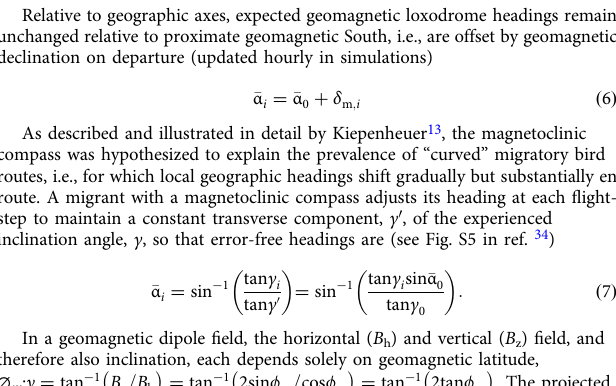
Fig. 8 Relative compass-course performance and cue favourability predicted by distance and spherical-geometry factors. a – i Route-optimized performance (arrival probability) vs. directional precision among fl ight-steps per modelled species (Table 2) for geographic loxodrome (purple hexagons), geomagnetic loxodrome (orange diamonds, right-adjusted for visibility), and TCSC courses (green circles). Species are arranged on the y -axis in increasing order of the product of the three performance gain factors (see text). Open symbols depict model-selected regression-estimated performance ð R 2 0 : 97 Þ for geographic loxodromes (hexagons) and TCSC courses (circles), including compass-speci fi c parameters factors governing convergence in mean heading with a number of steps, spherical-geometric effects and (for TCSC courses) fl ight-step distance. j Performance gain (%) vs. the minimum number of fl ight steps and the spherical geometry factor (Eq. (18)), for TCSC courses relative to geographic loxodromes (colour-coded inner hexagons) and geomagnetic loxodromes (colour-coded outer diamonds), here when additionally considering 15° compass precision including cue transfers where applicable, 15° drift, and 2.5° between-individual variability (for other error scenarios, see Supplementary Fig. 5). Photos as in Figs. 4, 6 and by a C. Giese, c P. Gomez (https://creativecommons.org/licenses/by-sa/3.0) and d Copyright © Albert Molenaar, via